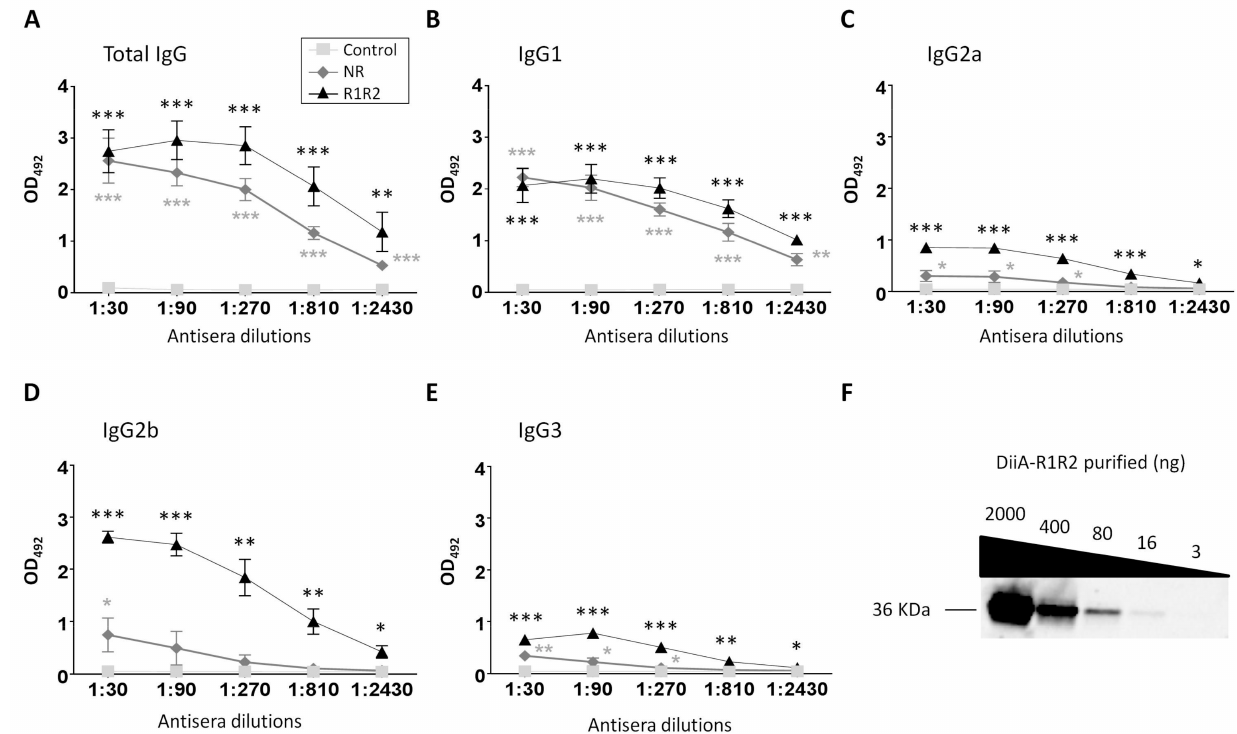
Figure 2. Antibody levels after immunization with control, DiiA-NR or DiiA-R1R2 preparations. Total IgG ( A ), IgG1 ( B ), IgG2a ( C ), IgG2b ( D ) and IgG3 ( E ). Pooled antiserum extracted from surviving immunized mice was used. Data are expressed as the average and standard deviation of three samples. Statistical significance of absorbance measures was analyzed respect to controls by Student’s t-test. * p < 0.05; ** p < 0.01; *** p < 0.001. ( F ) Verification of antiserum specificity by Western blot. Five-fold serial dilutions of purified protein and 1:500 serum dilution were